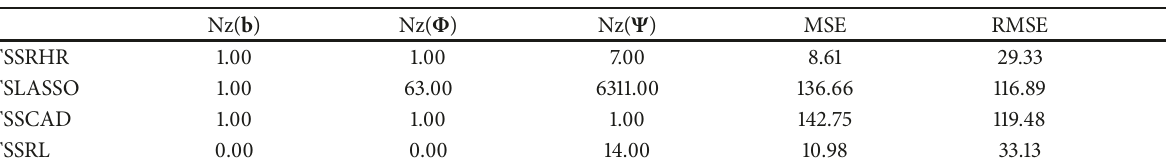
Table 2: The statistical performances of TSSRHR, TSLASSO, TSSCAD, and TSSRL. The performances are measured by number of nonzero elements of main effects, two-way interaction, three-way interactions, three-way interactions, MSE ( × 100), RMSE ( × 100), and computational costs (CC, in seconds, unless otherwise specified).